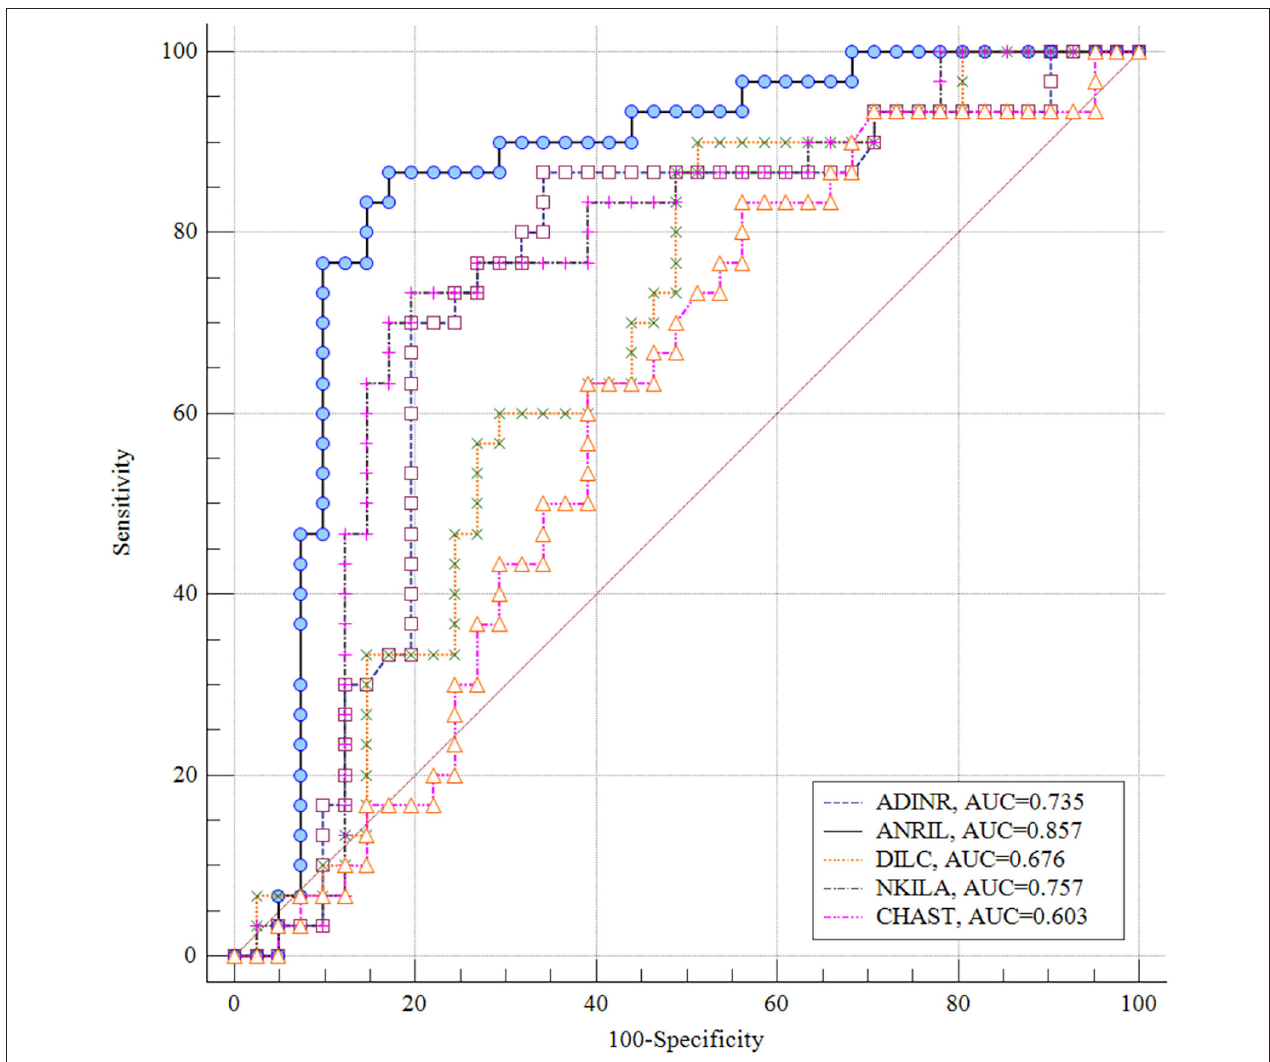
FIGURE 4 | Receiver Operating Characteristics (ROC) curves for appraisal of diagnostic value of ADINR , ANRIL , DILC , NKILA and CHAST in